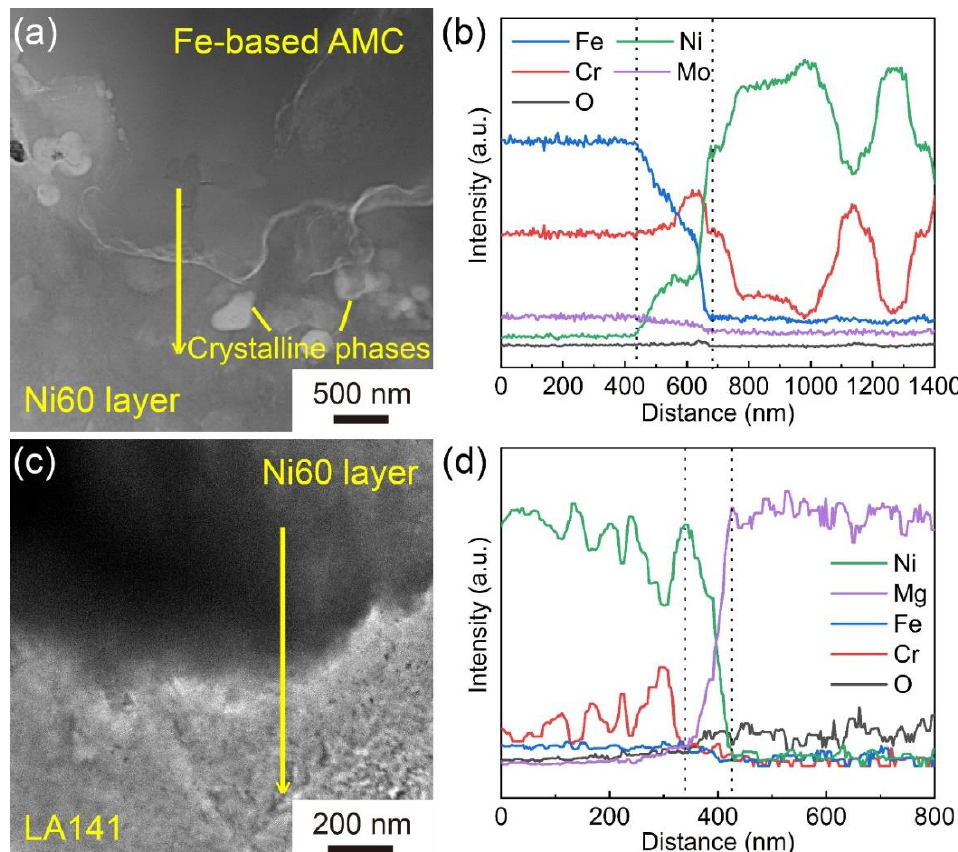
Figure 8. TEM image ( a ) and corresponding EDS line scanning profiles ( b ) of the Fe-based AMC/Ni60 layer interface in Coating D. TEM image ( c ) and corresponding EDS line scanning profiles ( d ) of the Ni60 layer/LA141 alloy substrate interface in Coating D.